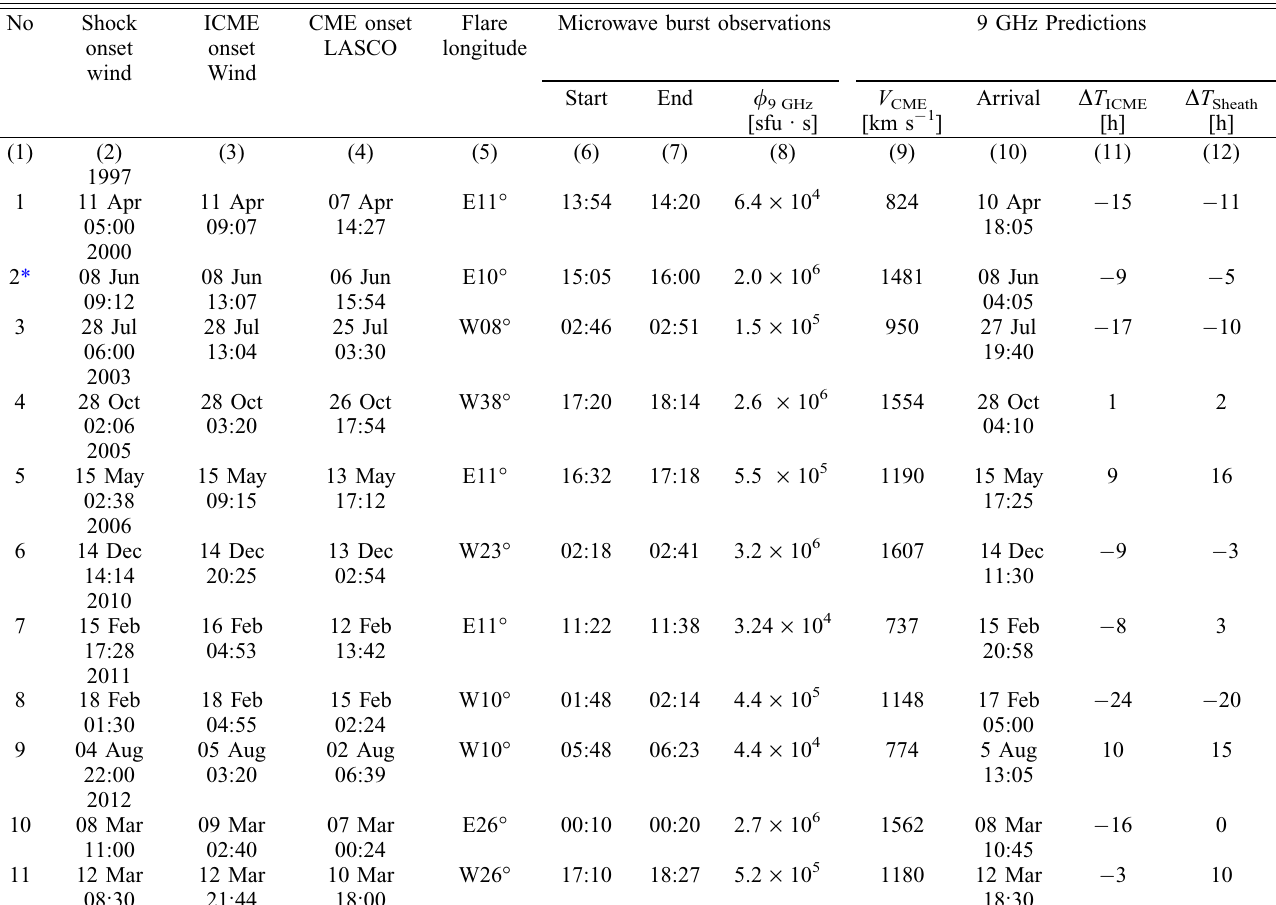
Table 3. Comparison between ICME arrival times measured at Wind spacecraft and predicted based on 9 GHz fluence: event number (col. 1), shock arrival (col. 2), ICME arrival (col. 3), CME onset (col. 4), flare longitude location (col. 5), microwave observations (cols. 6–8) and predictions based on the 9 GHz fluence (cols.